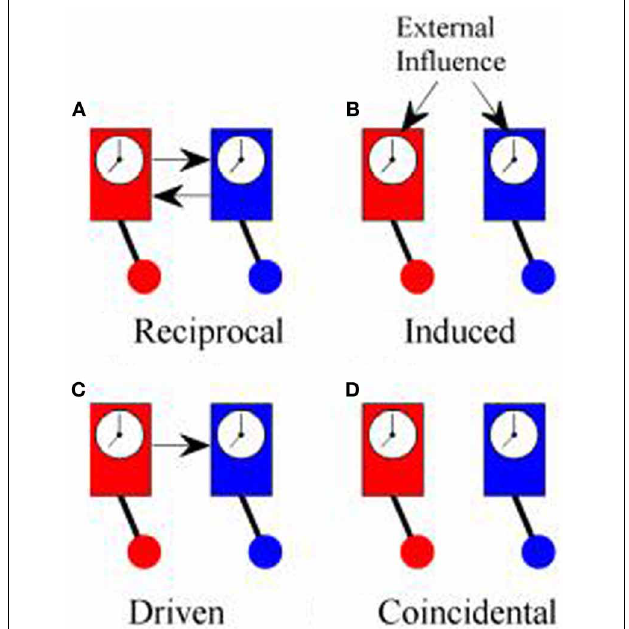
FIGURE 1 | Types of synchrony. (A) Shows “reciprocal” synchronization whereby the pendulums of the clocks swing in phase because there is reciprocal influence between the two; (B) shows “induced” synchronization whereby the phase of the pendulums of both clocks are influenced by a common external driver; (C) shows “driven” synchronization whereby the pendulum of one clock influences the phase of the pendulum of the other clock without any reciprocal influence; (D) shows “coincidental” synchronization where there is no coupling between the clocks but the pendulums remain in a fixed phase relationship to each other because they both swing at the same